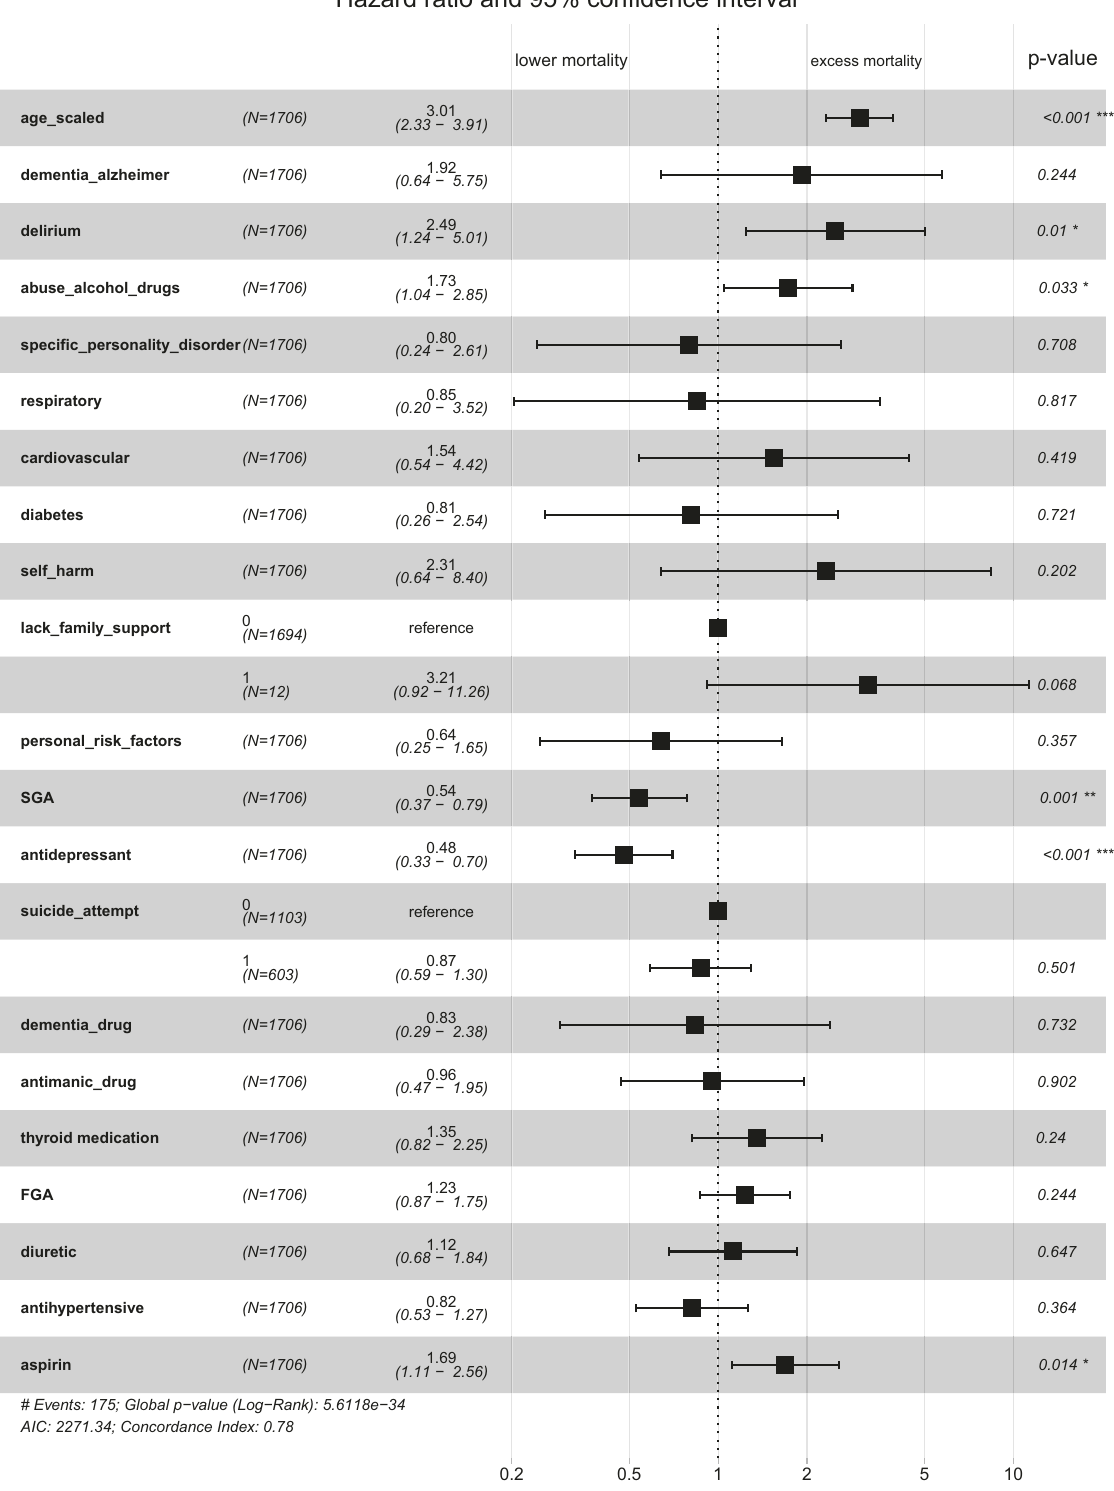
Fig. 2 Survival analysis for patients with schizophrenia using a Cox proportional hazards model. We show the hazard ratios associated with each feature and the con fi dence intervals. Use of second-generation antipsychotics (SGA) and antidepressants was associated with reduced risk of death in patients with schizophrenia. Alcohol/substance abuse and a diagnosis of delirium were associated with increased mortality. FGA: fi rst-generation